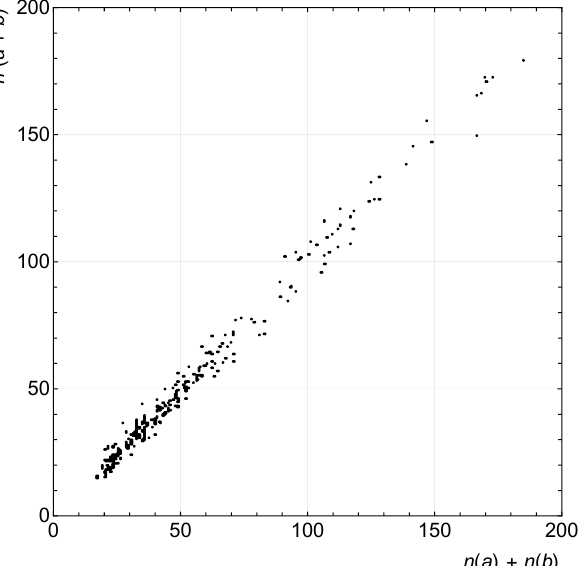
Figure 5. Approximate compositionality with linearity along the diagonal.